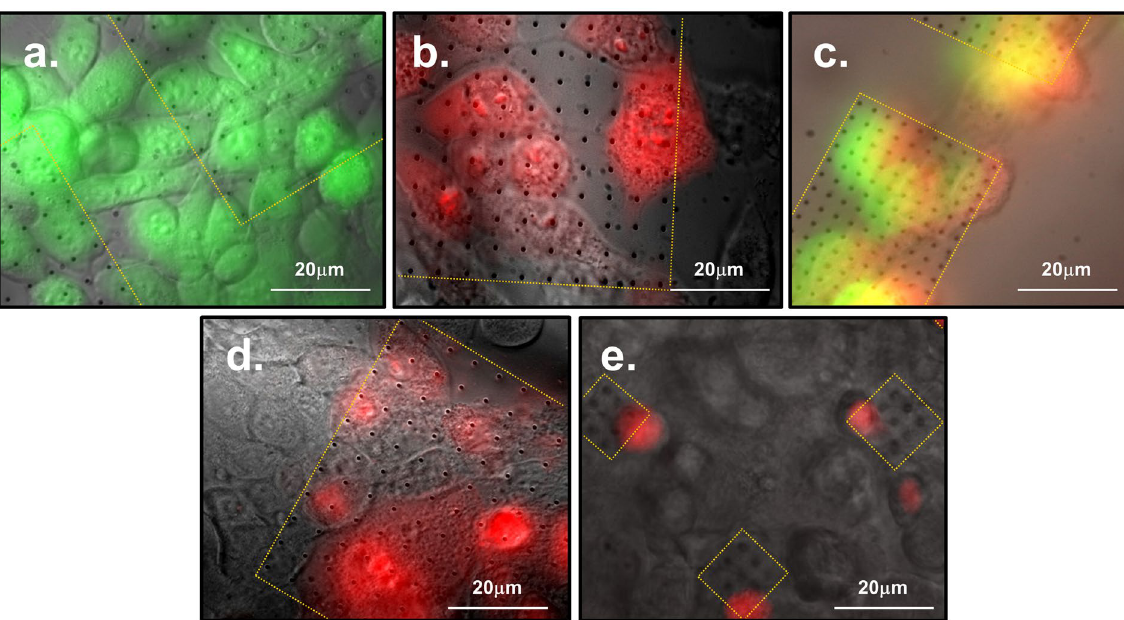
Figure 4. Images of electroporated cells by hollow nanoelectrodes and delivered with PI (red) and Calcein AM (green). Only the cells that lie on top of the 3D nanoelectrodes/nanochannels (inside the dotted yellow areas) are delivered after the soft-electroporation protocol, while the rest of the population remains unstained. ( a ) NIH-3T3 cells incubated with Calcein AM (green) in a live dead essay. ( b ) NIH-3T3 cells soft-electroporated and delivered with impermeable dye P.I. (red) through the nanofluidic electrodes. ( c ) NIH-3T3 cells stained both with Calcein AM and with PI after the soft-electroporation. The yellow color in the image is an artifact due to the double staining, green and red. ( d ) Cardiac muscle cells HL-1 electroporated with the soft-electroporation protocol and stained by P.I. through the hollow nanoelectrodes. ( e ) HL-1 cardiomyocytes electroporated and delivered with P.I. through small patterns (10 μ m by 10 μ m) of 3D hollow nanoelectrodes. Approximately only one cell per array has been stained, confirming the tight sealing between the plasma membrane and the flat SU8 passivation. This new design paves the way towards single cell